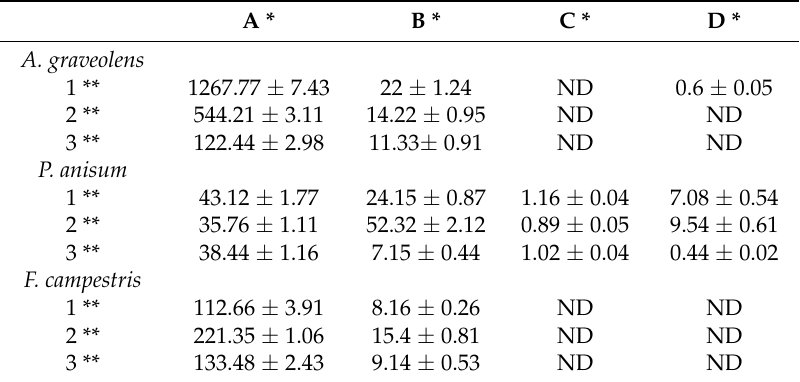
Table 2. Quantification of umbelliprenin in seed extracts of A. graveolens , P. anisum, and F. campestris (Extracts used in the subsequent tests are marked in